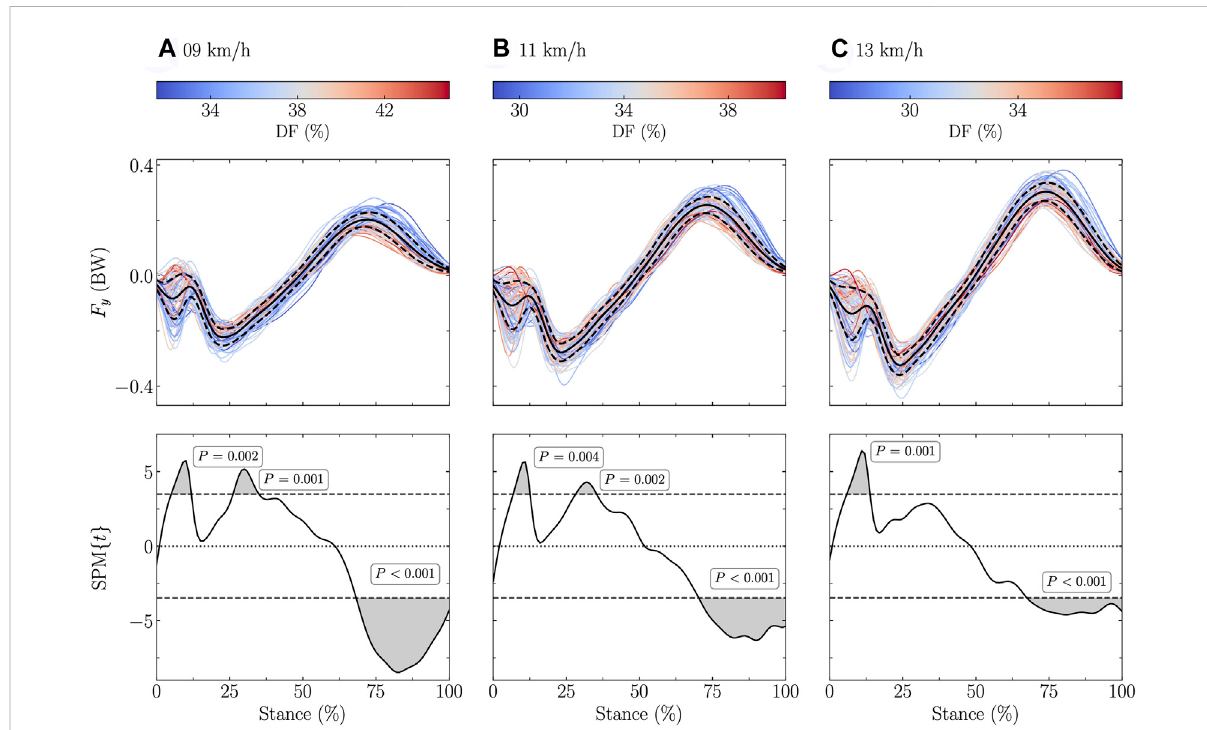
FIGURE 3 Statistical parametric mapping (SPM) analysis, i.e., t-statistics (SPM{t}), of the linear relationship between the fore-aft ground reaction force (F y ) andthedutyfactor(DF)alongtherunningstancephaseat (A) 9 km/h, (B) 11 km/h,and (C) 13 km/h. Intheupperpanels,F y ,expressedinbodyweight (BW),isdepictedforeachparticipant(thecolordependsontheDFvalue)andforthemean(blackline)±standarddeviation(dashedblackline)overall participants. In the lower panels, the black dashed horizontal lines represent the critical (parametric) threshold while the portion of the running stance phase which is statistically signi fi cant ( p ≤ 0.017; Bonferroni correction was applied to take into the three tested speeds) is given by the gray shaded